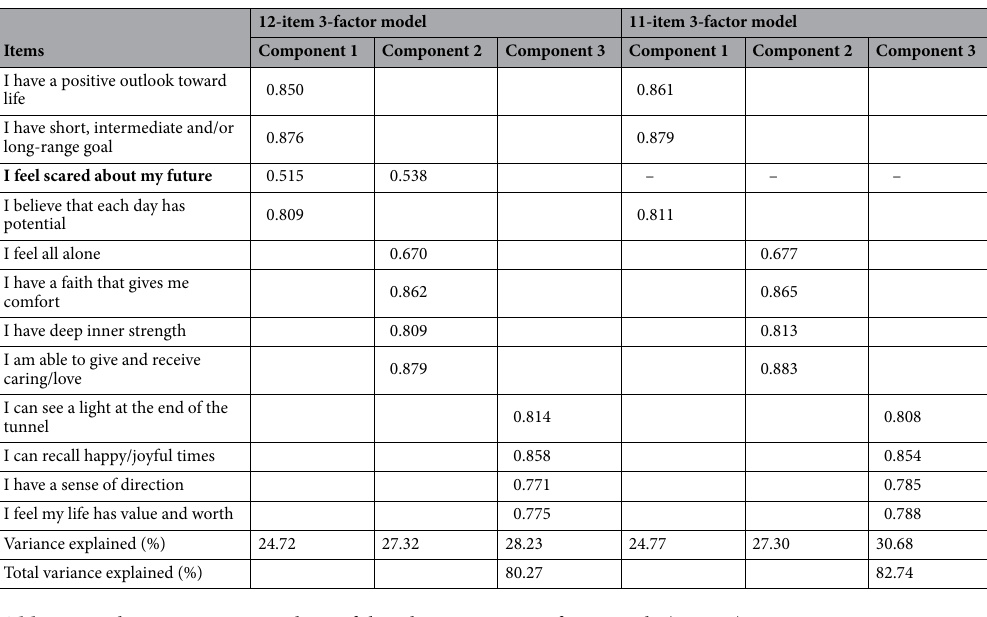
Table 2. Exploratory Factor Analysis of the Chinese version of HHI Scale (n = 206). Component 1, Inner sense of temporality and future; Component 2, Interconnectedness with self and others; Component 3, Inner positive readiness and expectancy. Cross-loaded item is in bold.